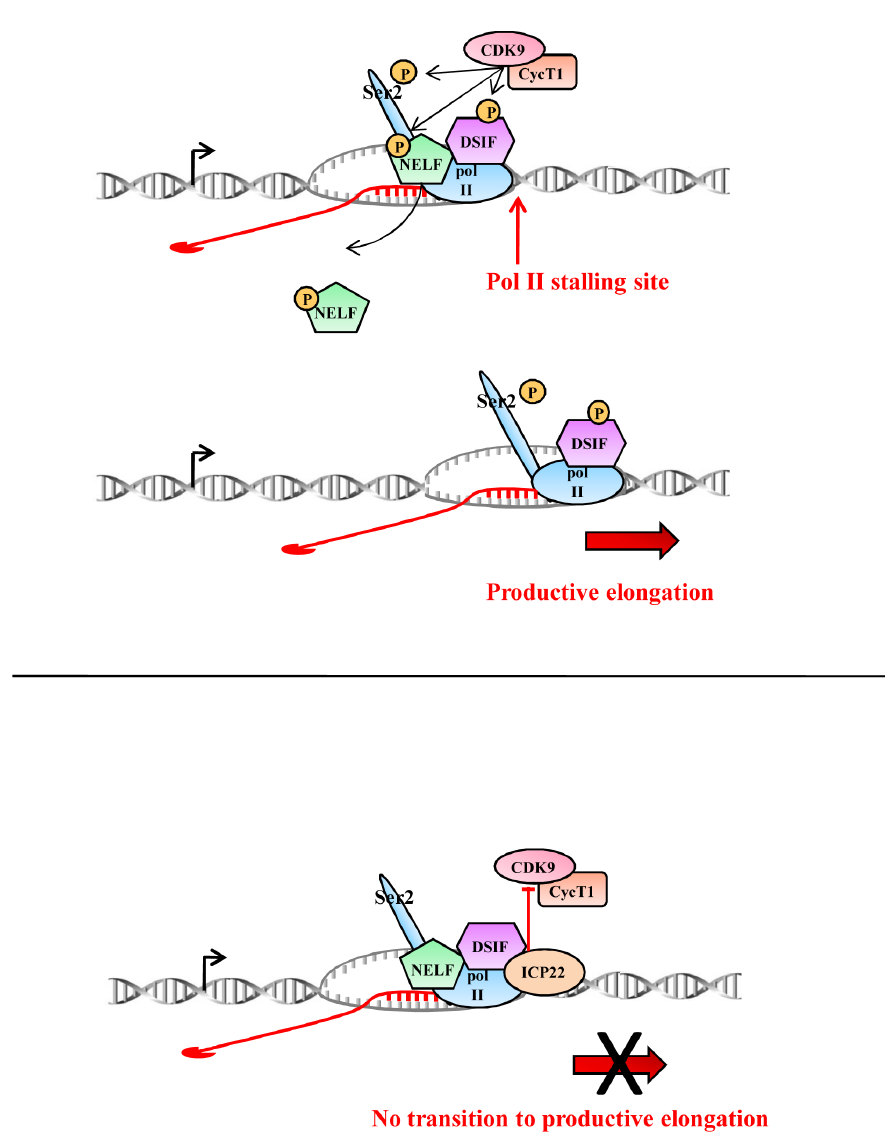
Figure 6. Model for the role of ICP22 in inhibition of pol II CTD Ser2 phosphorylation. In uninfected cells (top panel), the negative elongation factor (NELF) and the DRB-sensitivity-inducing factor (DSIF) enhance pol II stalling. Subsequent recruitment of P-TEFb allows phosphorylation of DSIF, NELF and Ser2 of the pol II CTD, which leads to productive elongation. In the context of HSV-1-infected cells (bottom panel), ICP22 associates with P-TEFb and inhibits the kinase activity of CDK9 at the site of transcription, as indicated by the loss of phosphorylation of Ser2 of the pol II CTD, NELF and DSIF. As a consequence, the transition to productive elongation is inhibited. Interaction between ICP22 and pol II is not necessary to recruit ICP22 to genes or inhibit CDK9 when ICP22 is ectopically expressed in cells on its own. However, the interaction between pol II and ICP22 may be necessary to recruit ICP22 to host cell genes in HSV1-infected cells. Alternatively, interaction between ICP22 and pol II may play a role in regulation of viral gene expression by